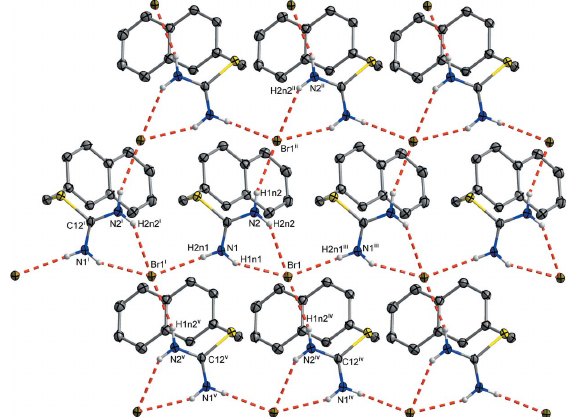
Figure 2 Figure 3 The charge-assisted hydrogen bonds in the title compound. Hydrogen The bilayers formed in the title compound by charge-assisted hydrogen atoms not involved in hydrogen bonding are omitted for clarity. bonds, depicted in red, and dipole–dipole interactions, depicted in green. Symmetry codes: (i) x , y (cid:3) 1, z ; (ii) x , (cid:3) y + 3 Hydrogen atoms not involved in hydrogen bonding are omitted for , z (cid:3) 1 ; (iii) x , y + 1, z ; 2 2 clarity. (iv) x , (cid:3) y + 3 , z + 1 ; (v) x , (cid:3) y + 1 , z + 1 . 2 2 2 2